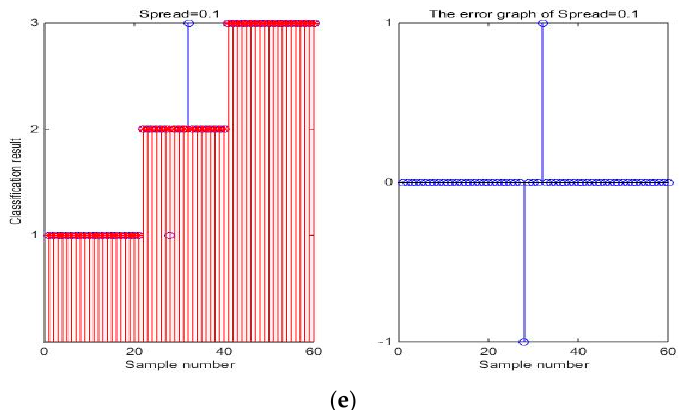
Figure A2. Network training effect under different spread parameters. ( a ) Spread = 1.0; ( b ) Spread = 0.8; ( c ) Spread = 0.5; ( d ) Spread = 0.2; ( e ) Spread = 0.1.